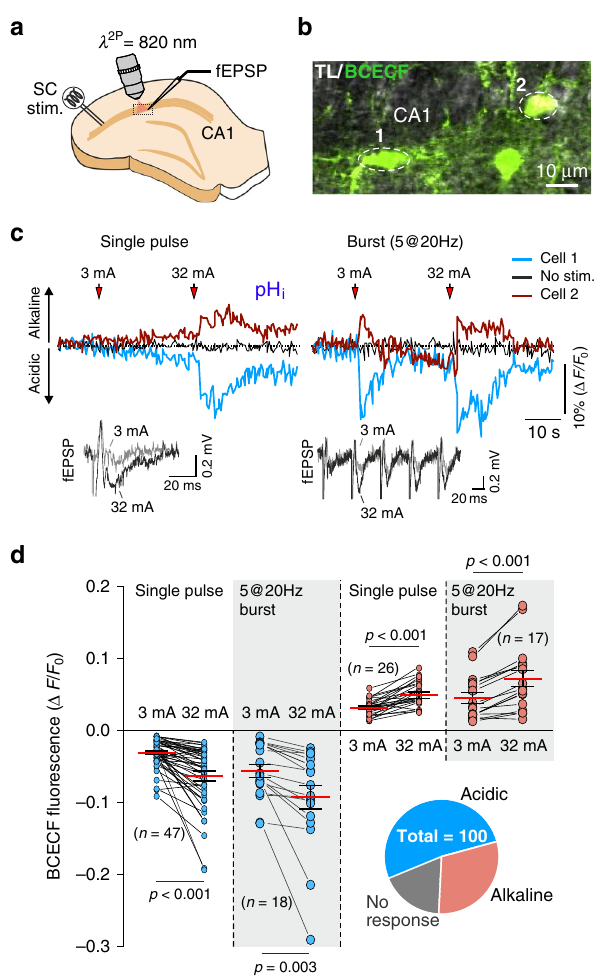
Fig. 2 Neuronal activity-dependent intracellular pH responses in hippocampal astrocytes in vitro. a Schematic drawing of the experimental design. Electrical stimulation of Schaffer collateral (SC) fi bres was applied during two-photon imaging of pH i in hippocampal astrocytes and recordings of fi eld excitatory postsynaptic potentials (fEPSP). b Representative image illustrating astrocyte cell bodies and process loaded with BCECF and surrounding CA1 pyramidal cells (not stained).